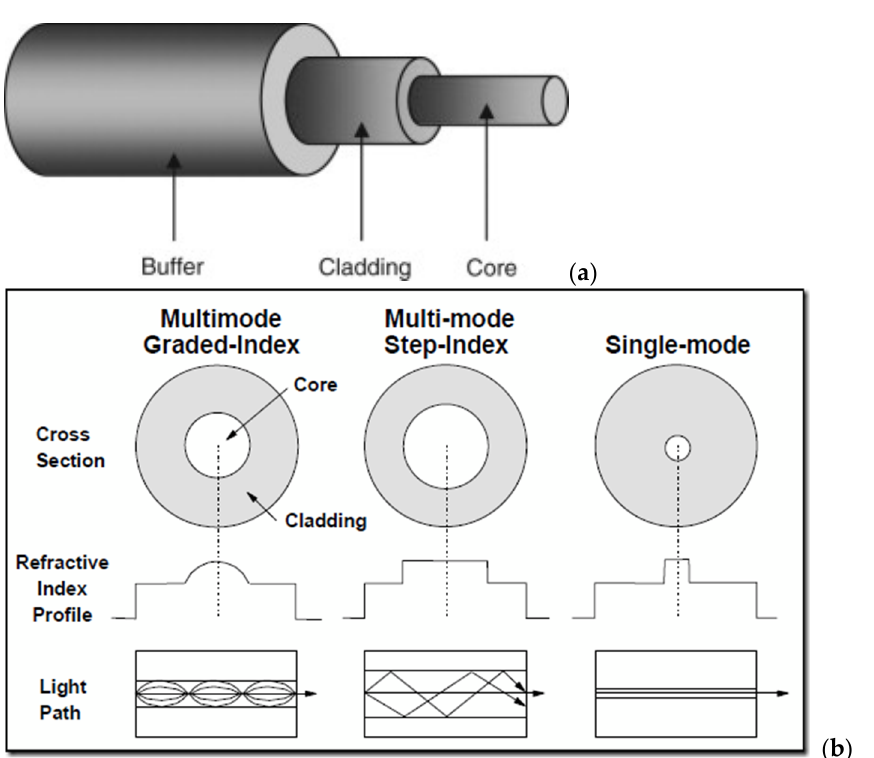
Figure 1. ( a ) Structure of optical fibre [19]. ( b ) Fibre dispersion and modal dispersion [20,21].